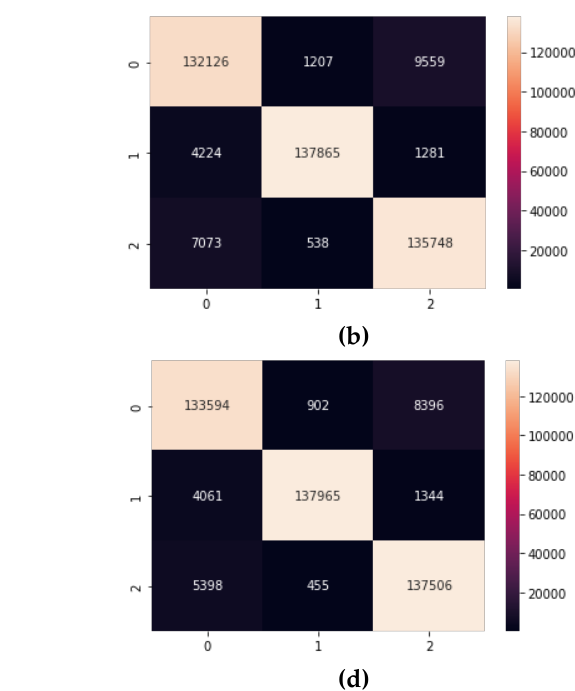
(d) Figure 9. The Confusion Matrices for the Deep Learning algorithms, listed as: (a) DNN in setting 1; (b) DNN in setting 2; (c) LSTM in setting 1; (d) LSTM in setting 2. Again, and as described in figures 10 and 11, the effect of class imbalance is evident in the AUC-ROC curve, especially in the case of the Random Forest and Decision Tree algorithms. We can clearly see that in the setting 1, the difference in true positive rate for a particular value of false positive rate is more as compared to that in the setting 2.